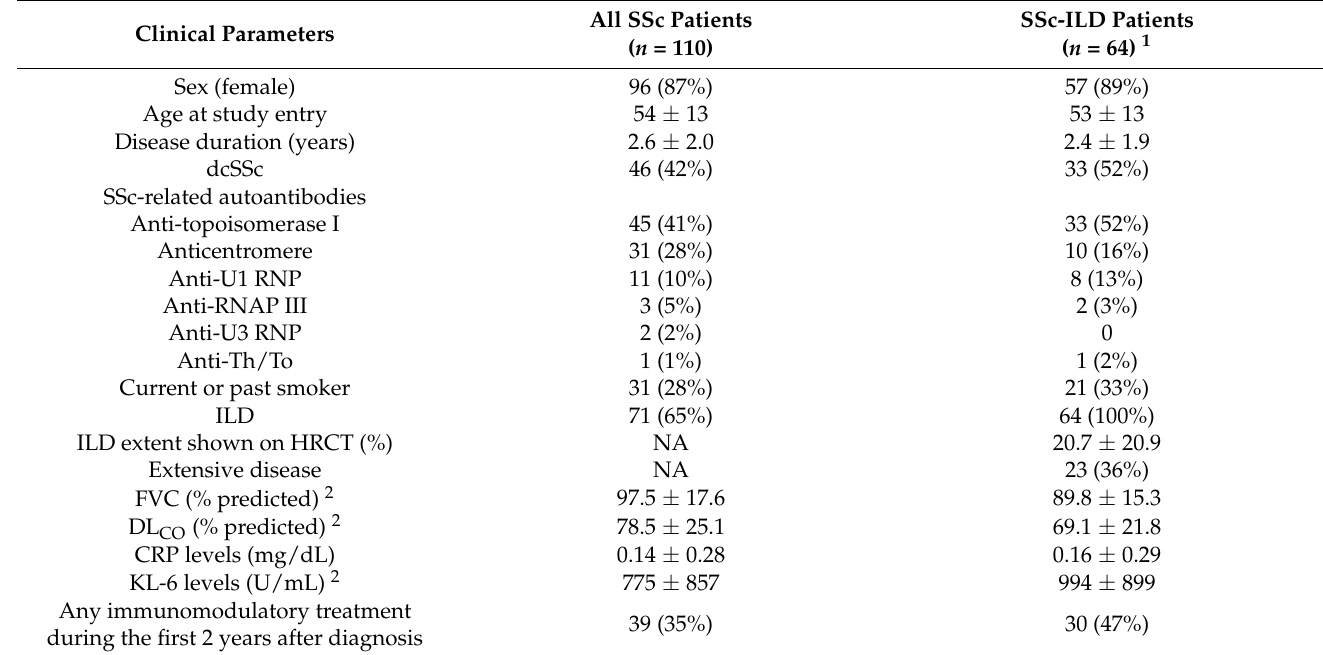
Table 1. Baseline characteristics and immunomodulatory treatment during the first 2 years after diagnosis in SSc patients used for analyses. Clinical